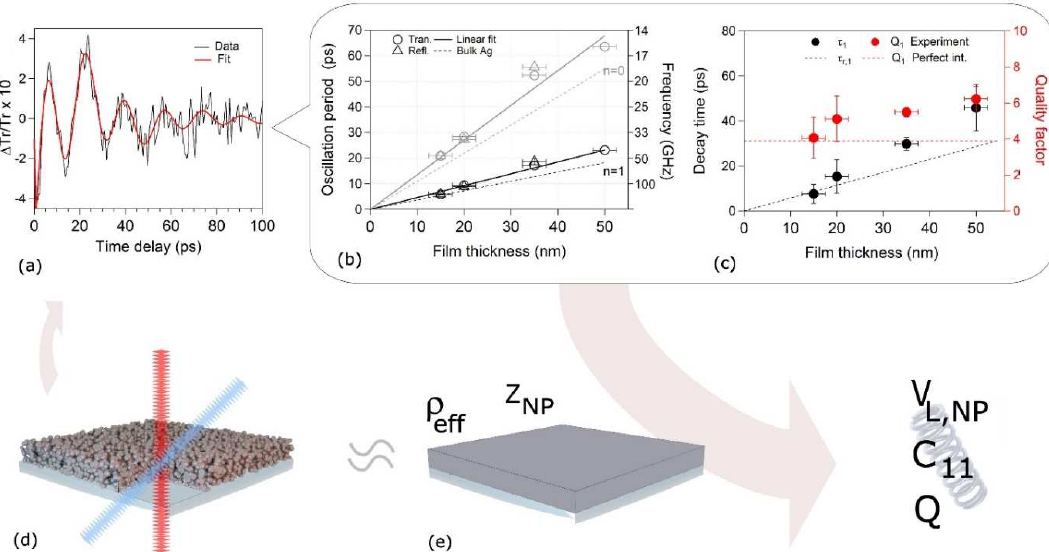
Figure 8. ( a ) Relative transmission variation vs. delay time acquired on a 35 nm thick NP film. Data (black line) and its fit are based on two damped oscillators (red line). ( b ) Oscillation period (left axis) and frequency (right axis) vs. film thickness obtained from transmission (circle) and reflection (triangle) geometry. Fundamental ( n = 0) breathing mode data are in gray and first harmonic ( n = 1) are in black. Full lines: linear fit through the origin of the data. Dashed lines: fundamental ( n = 0) and first harmonic ( n = 1) breathing mode period calculated from Equation (4), assuming bulk Ag values for the thin film. ( c ) Attenuation time (black, left axis) and quality factor (red, right axis) for the n = 1 breathing mode vs. film thickness. Markers: experimental data. Dashed line: theoretical values calculated from Equation (5) adopting the perfect interface model between the sapphire substrate and a homogeneous film with the same density and longitudinal sound velocity as those experimentally obtained for the Ag NP films, as exemplified in the scheme of panel ( e ). Adapted from ref. [37]; further permission related to the material excerpted should be directed to the ACS. ( d ) Scheme of the Ag NP film deposited on sapphire, evidencing the pump (blue) and probe (red) laser beams.